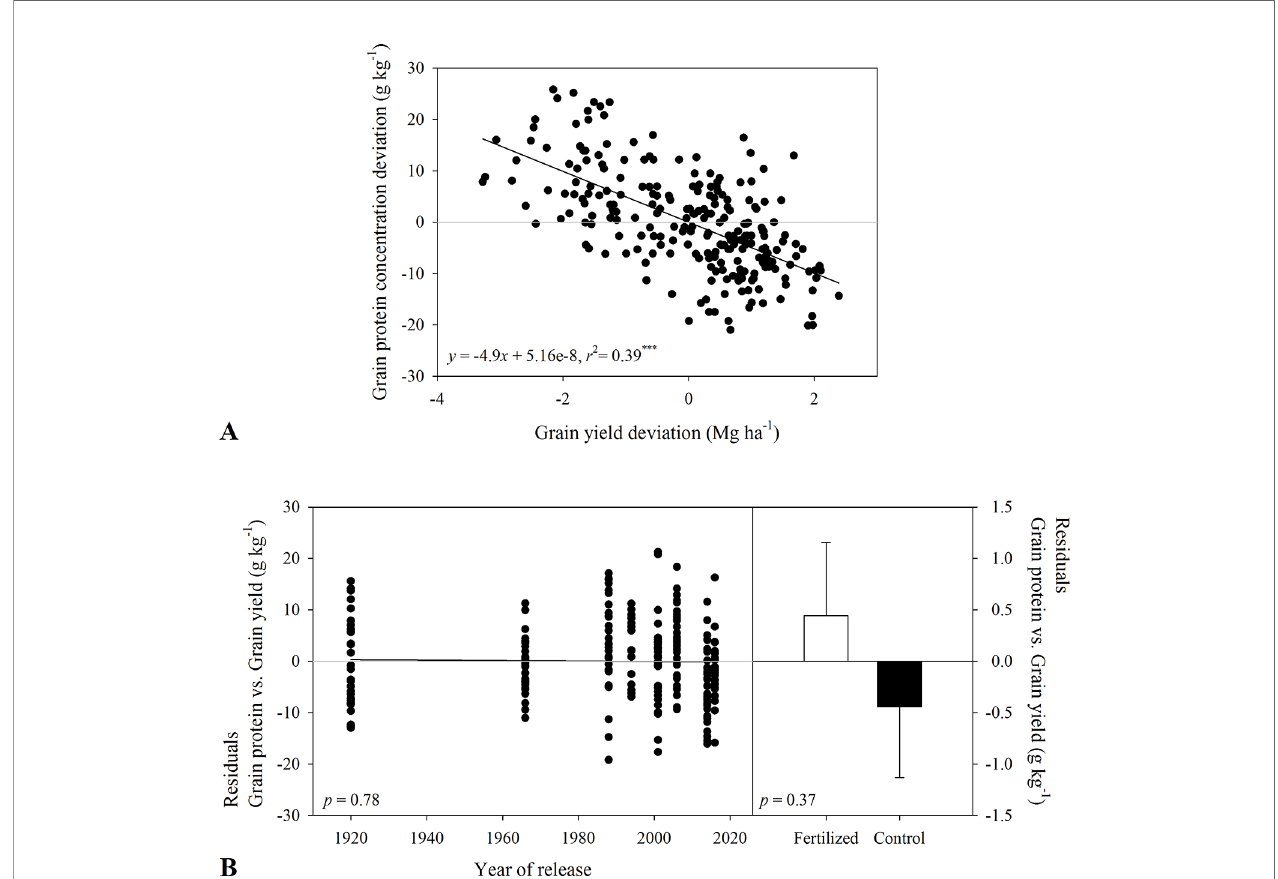
FIGURE 3 | Relationship between (A) grain protein concentration deviation and grain yield deviation for varieties released between 1920 and 2016. Residuals of the regression (B) as affected by year of variety release or in-furrow fertilizer treatment and control (bars show mean and standard error). Values correspond to the data of four site-years during two growing seasons (2016-2017 and